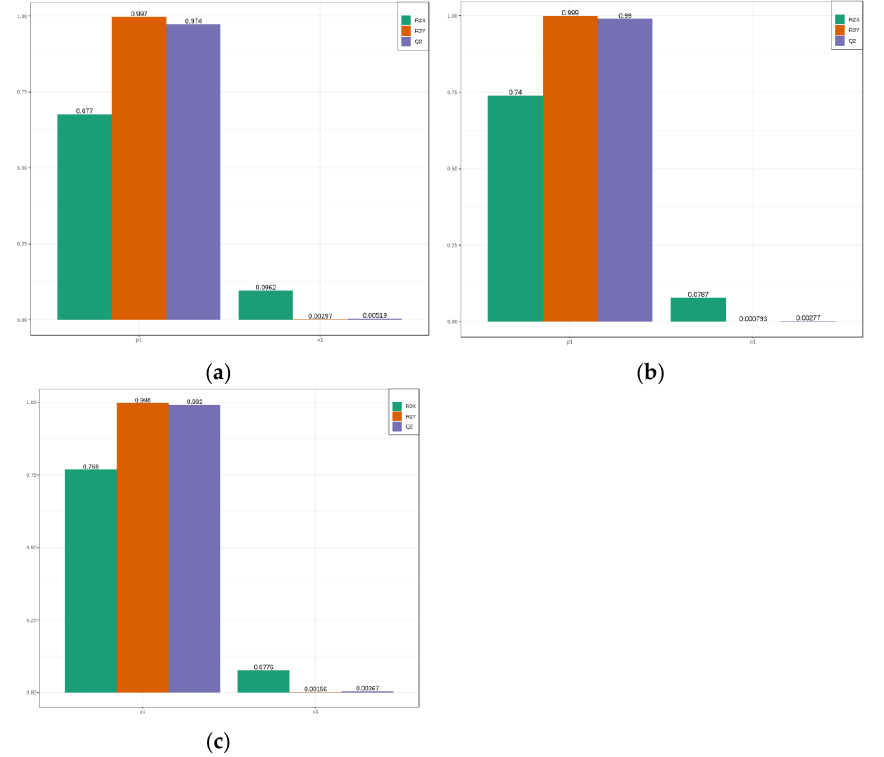
Figure 4. OPLS-DA model plots for ( a ) GZ2 vs. CK; ( b ) GZ4 vs. CK; ( c ) GZ4 vs. GZ2. Table 1. The 49 differential flavonoid metabolites in GZ2 vs. CK and GZ4 vs. CK.